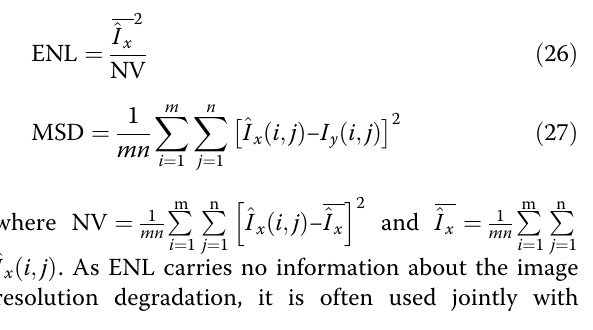
Table 3 Obtained PSNRs for denoising the eight test images in NSST domain when σ 2 every image, and the average PSNR is reported Barbara Lena House Boat Goldhill Fingerprint Cameraman